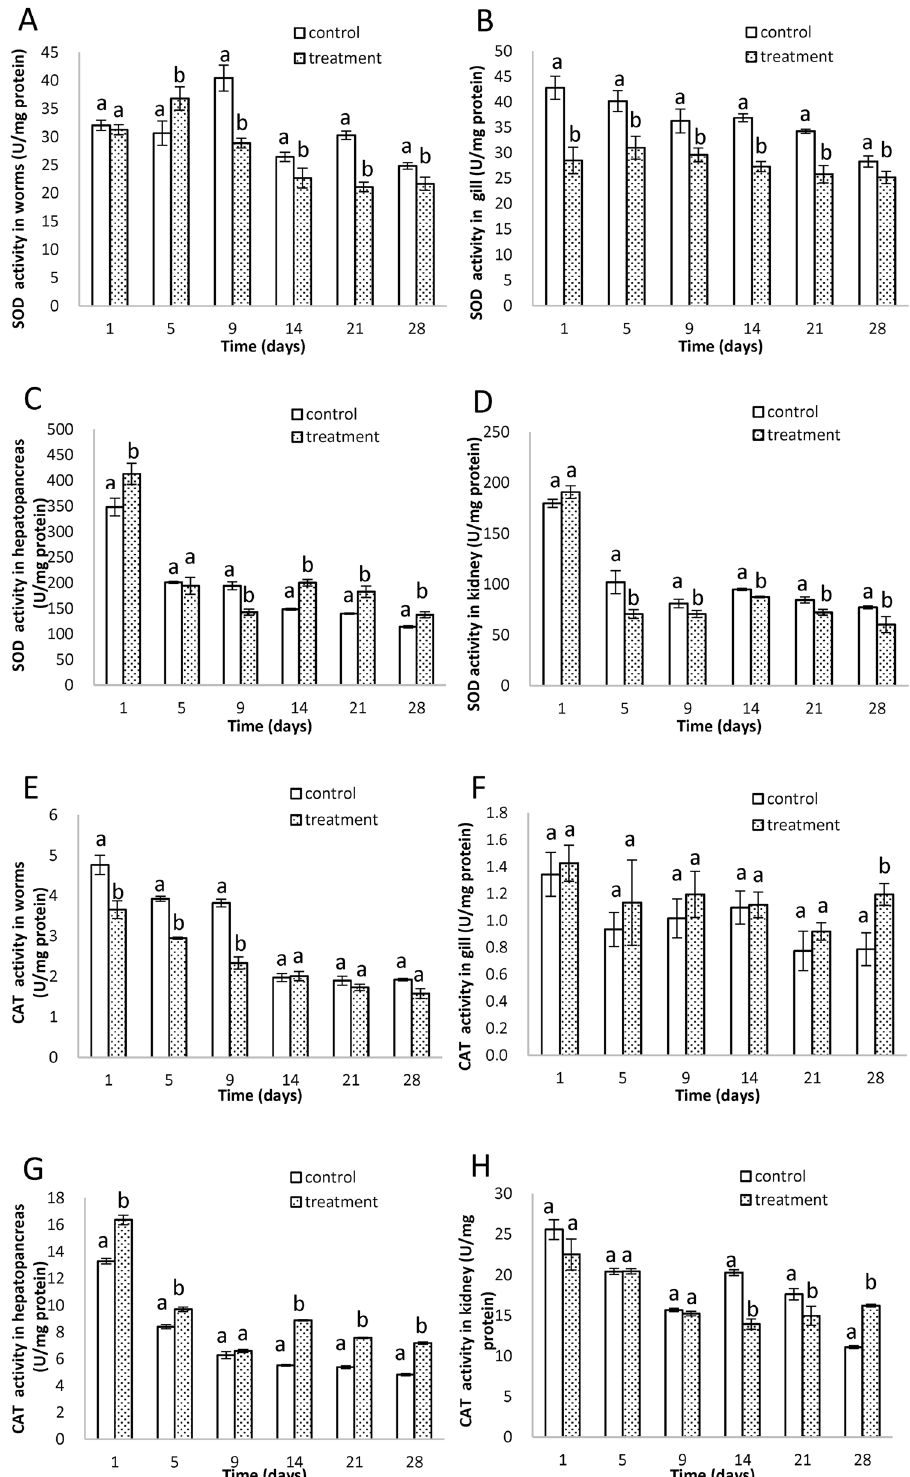
Figure 5. The activities of superoxide dismutase activity (SOD) in T. tubifex ( A ), gill ( B ), hepatopancreas ( C ), and kidney ( D ). The activities of catalase activity (CAT) in T. tubifex ( E ), gill ( F ), hepatopancreas ( G ), and kidney ( H ). Different letters denote significant difference at the same time point (p < 0.05, S-N-K test), bars are standard deviation (SD). All samples were extracted and analyzed in